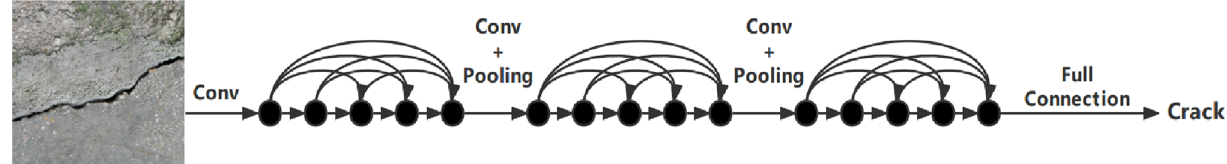
Fig. 5 DenseNet network architecture